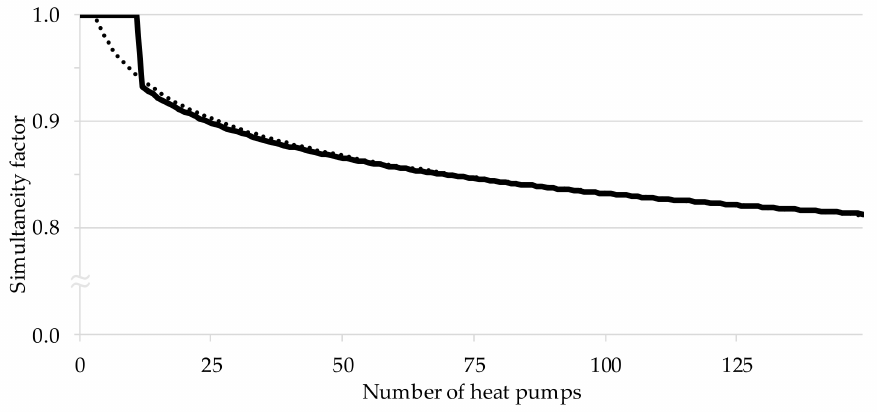
Figure 7. Simultaneity factors for heat pumps based on [53].